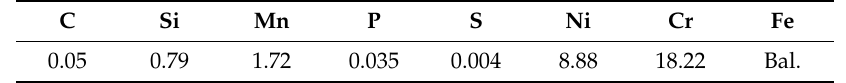
Table 1. Chemical composition of the stainless-steel (SUS304) tube used in this study (mass